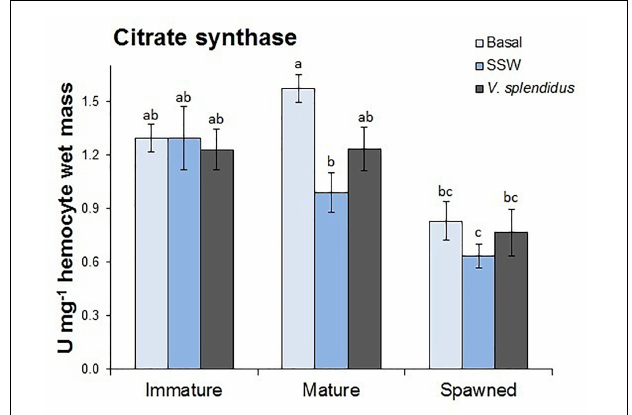
FIGURE 2 | Effects of in vivo challenge with V. splendidus on citrate synthase (CS) activity in hemocytes form immature, mature, and spawned A. purpuratus . Values associated with the same letter belong to the same subset based on a FDR-BY (false discovery rate) post hoc test (Benjamini and Yekutieli, 2001) ( n = 4–8 per condition and treatment).